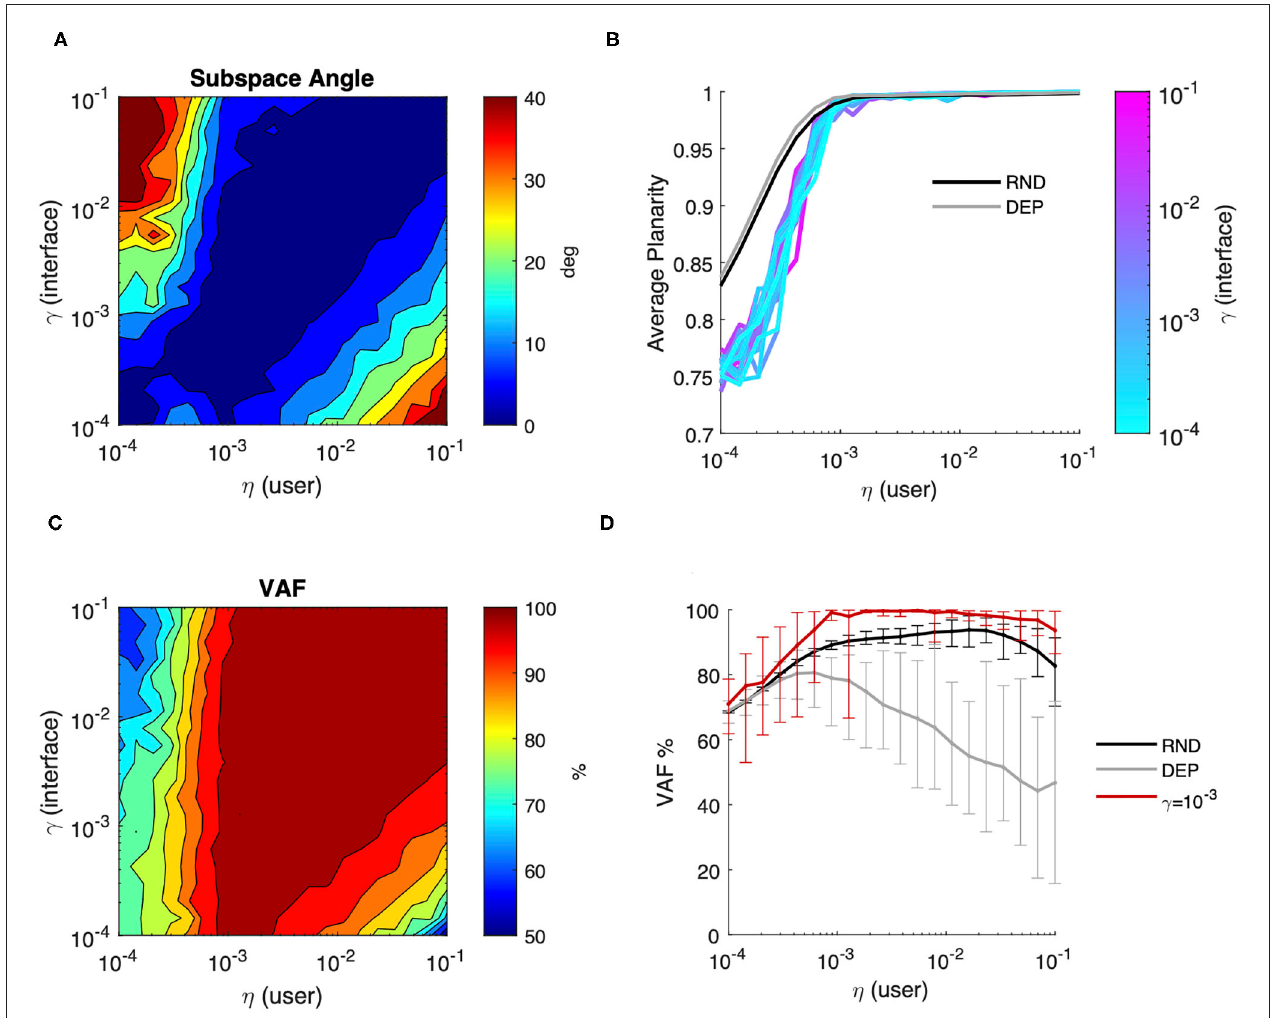
FIGURE 5 | User-interface joint performance after co-adaptation. Final performance computed as the average value over the final 200 iterations of joint learning across all combinations of user ( η ) and interface ( γ ) rates of adaptation; (A) average Subspace Angle between the maximum variance 2D approximation of the user’s covariance and the interface map. Levels indicate steps of 5 degrees; (B) average Planarity (colored lines). The x-axis represents the learning rate of the user, while the color represents the interface adaptation rate. The gray and black lines represent the final Planarity obtained in the case of user learning with dependent and independent samples, respectively; (C) average Variance Accounted For by the interface map. Levels indicate steps of 5%; (D) comparison of the average percentage of variance accounted for by the interface for different degrees of user learning in the case of a static interface and independent samples (RND—black line) or dependent samples (DEP—gray line) and after interface coadaptation with γ = 10 − 3 (red line). The error bars represent the 95% confidence interval over 20 simulation